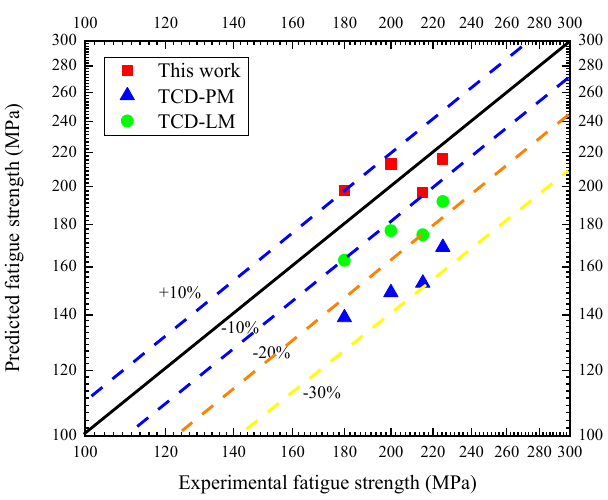
Figure 10. Scatter plots of experimental fatigue strength vs. predicted fatigue strength.